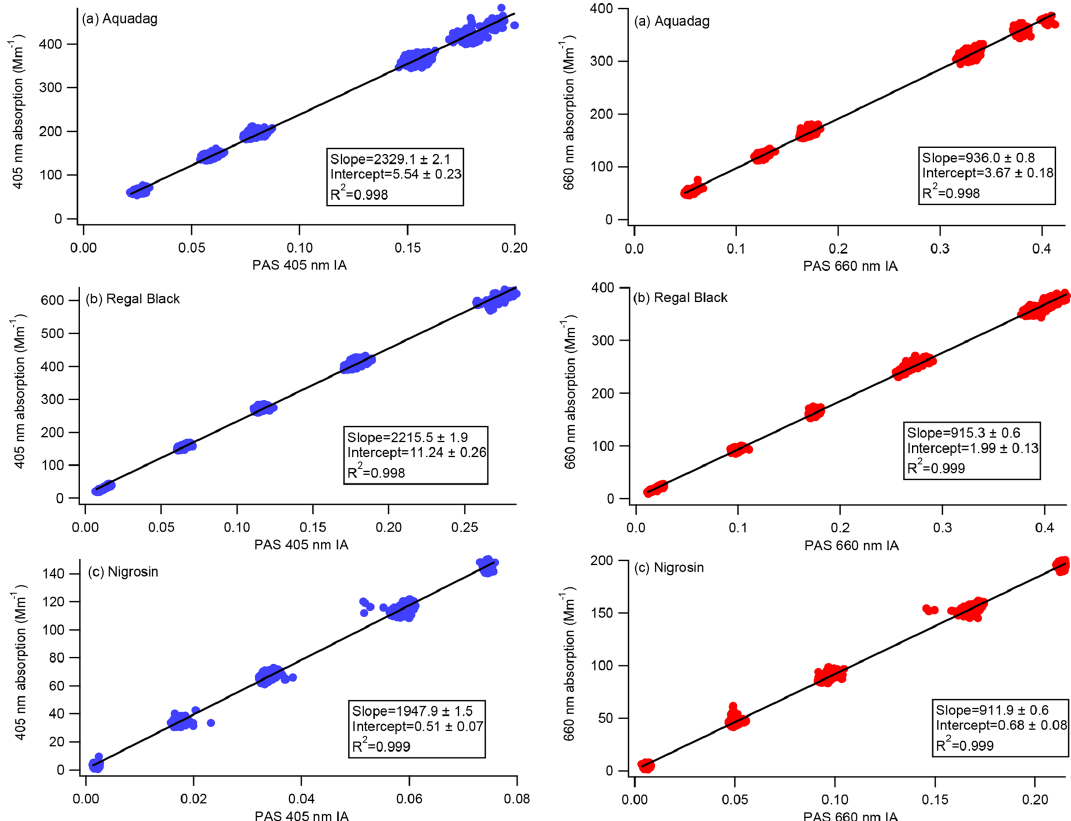
Figure 5. Calibration curves representing CAPS PM SSA absorption versus PAS integrated area (IA). The PAS 405nm cell is on the left, and the 660nm cell is on the right. A line is fit to the data, the slope of which gives the relationship between absorption and IA. Intercepts are allowed to vary in order to achieve the most accurate slopes based on higher absorption levels where the accuracy of the CAPS PM SSA is highest. During operation in the field, both instruments are frequently zeroed based on filter measurements, meaning the intercept of the calibration slope is not